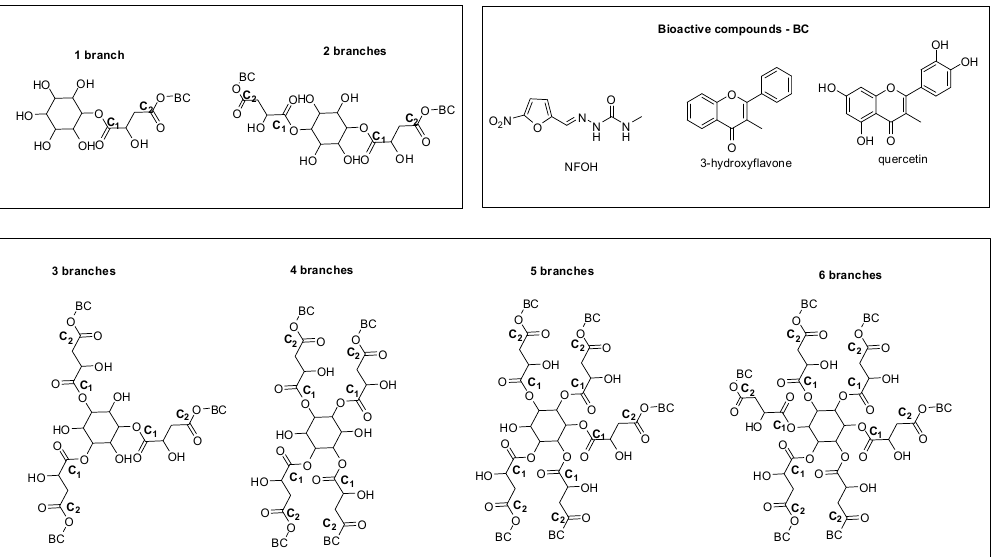
Figure 11. Dendrimer prodrugs for neglected diseases containing 3-hydroxyflavone, NFOH and quercetin [58].